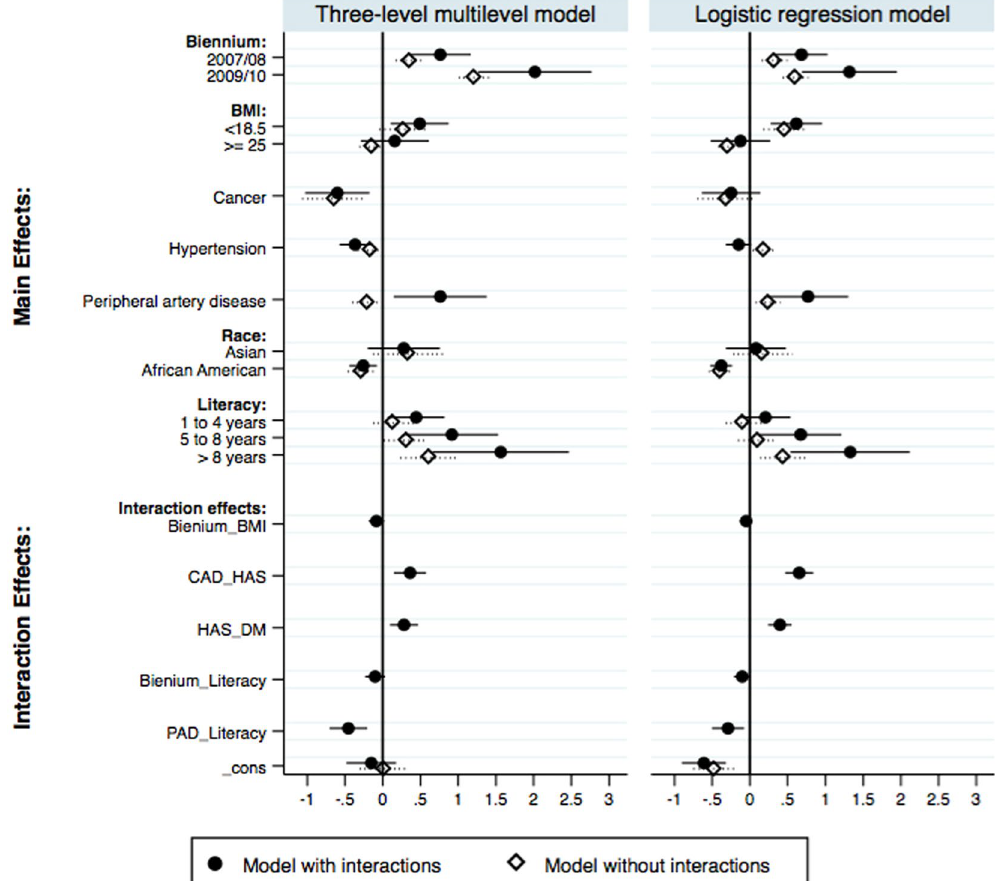
Figure 2. Factors associated with initial PD modality. Values below 0 favour starting on CAPD whilst values above 1 favour starting on APD; the reference group of Biennium was 2005/06; for BMI was 18.5 to < 25; for Race was White race; and for Literacy illiterates were the reference group. In the mixed model patients were nested in clinics and clinics nested in regions. Loglikelihood ratio favoured the multilevel